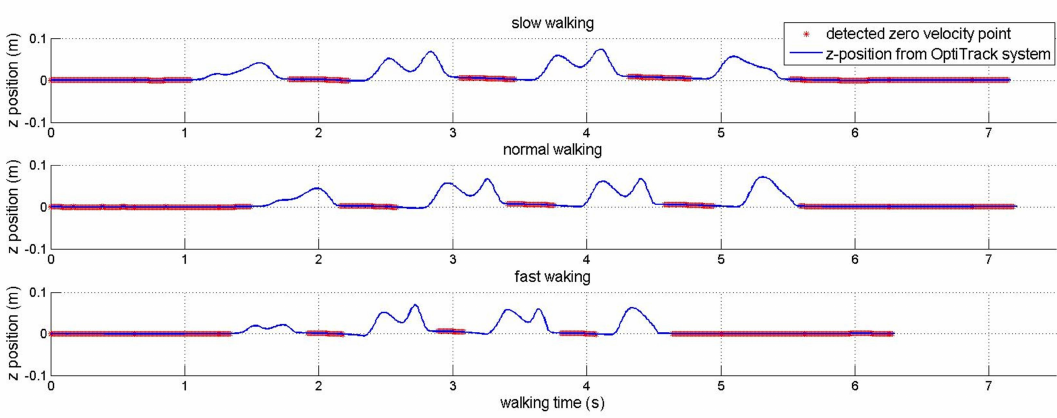
Figure 14. z -position of foot and detected zero velocity